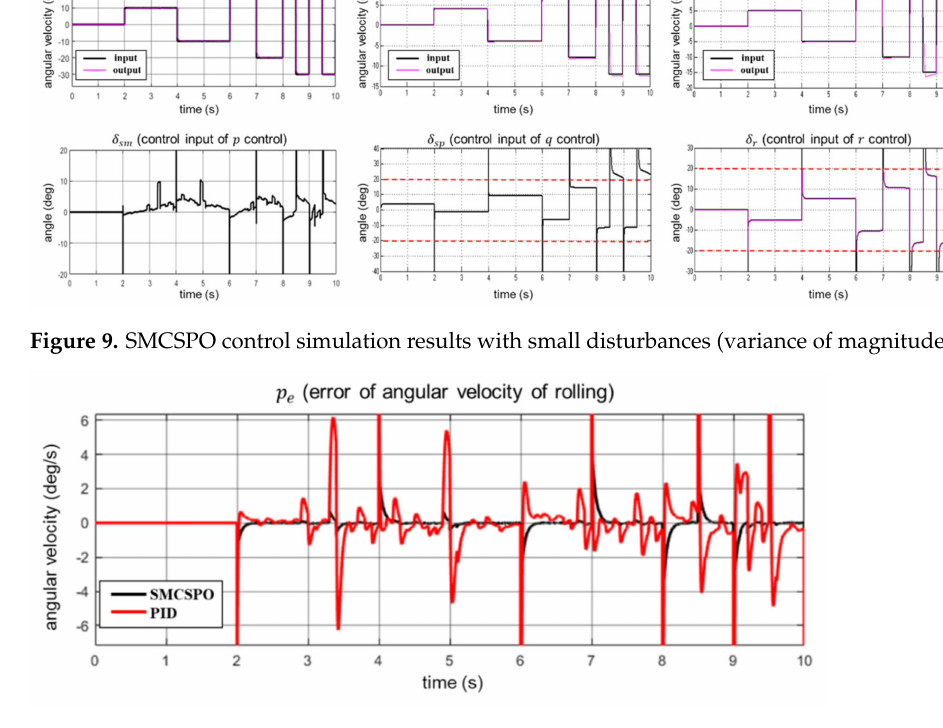
Figure 10. Rolling velocity’s error comparison of SMCSPO and PID controller with small disturbances (variance of magnitude =